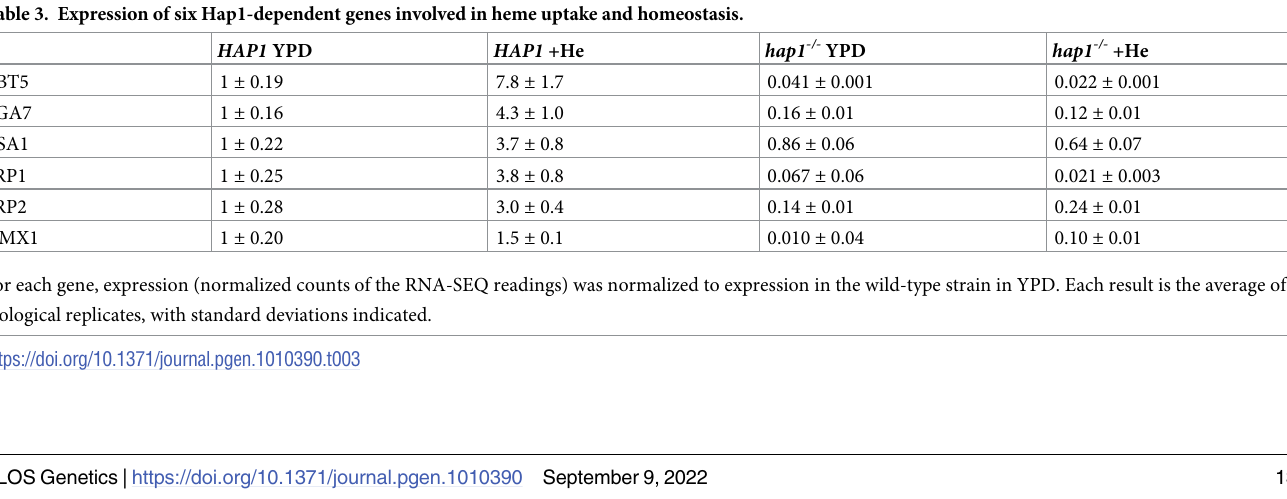
Table 3. Expression of six Hap1-dependent genes involved in heme uptake and homeostasis. HAP1 YPD HAP1 +He hap1 -/- YPD hap1 -/- +He RBT5 1 ± 0.19